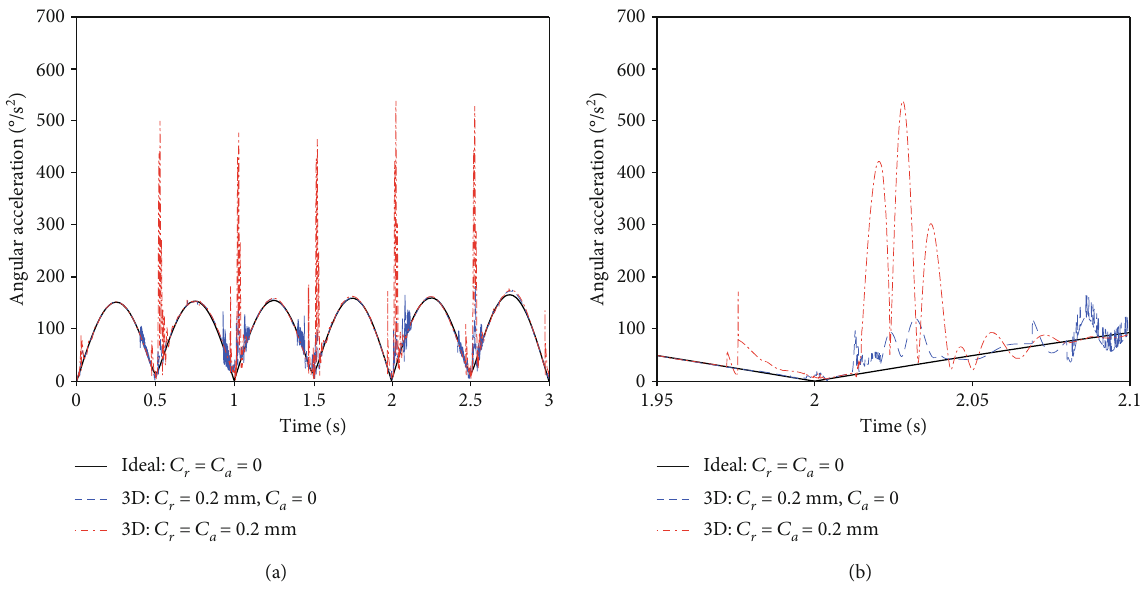
Figure 9: Angular acceleration of the antenna: (a)angular acceleration; (b) partial